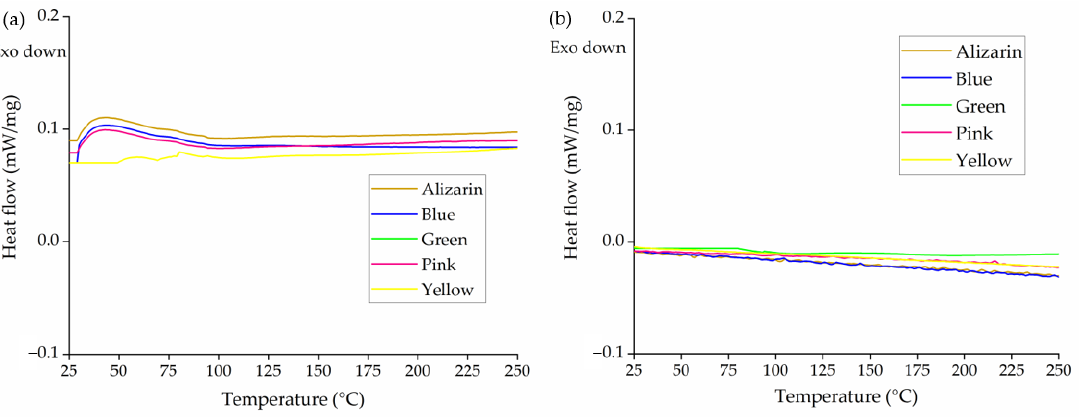
Figure 2. DSC thermograms of five colorants during ( a ) the heating cycle and ( b ) the cooling cycle.